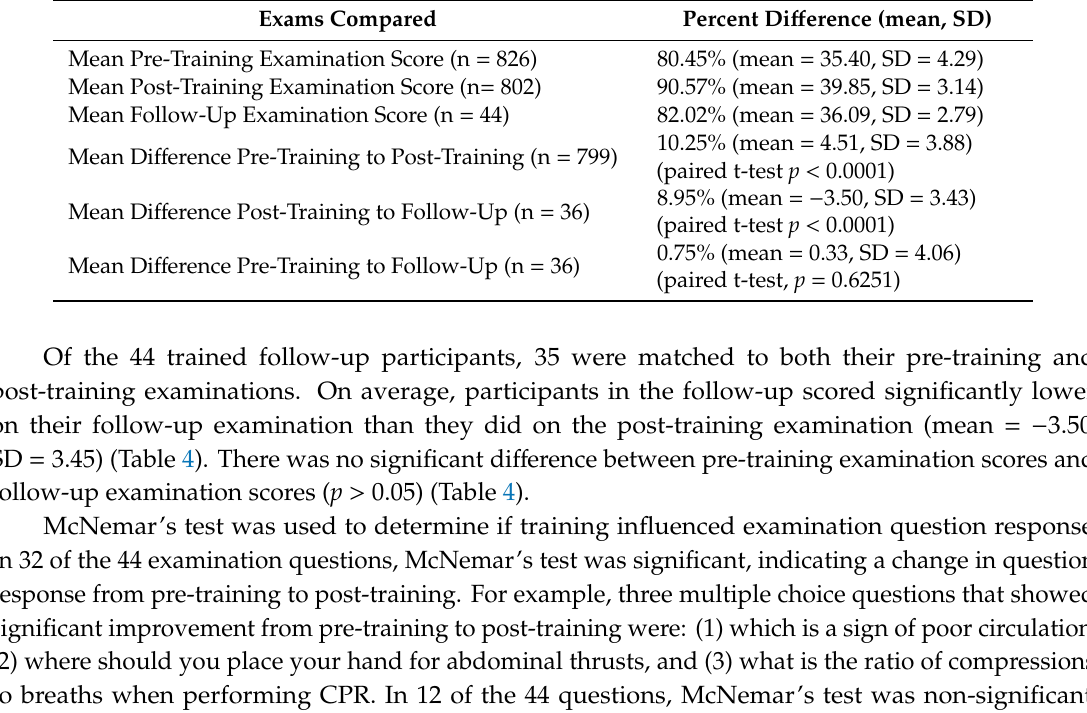
Table 4. Participant examination scores (pre-training, post-training, and